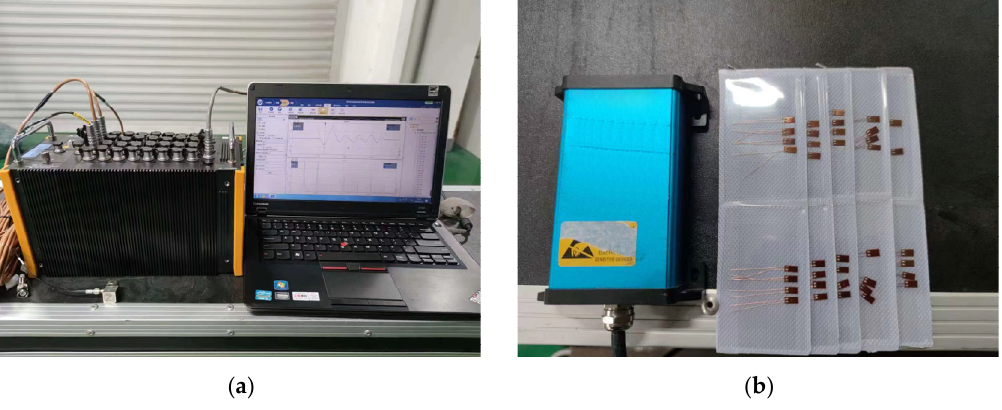
Figure 18. ( a ) Experiment Testing System and ( b ) Sensors.